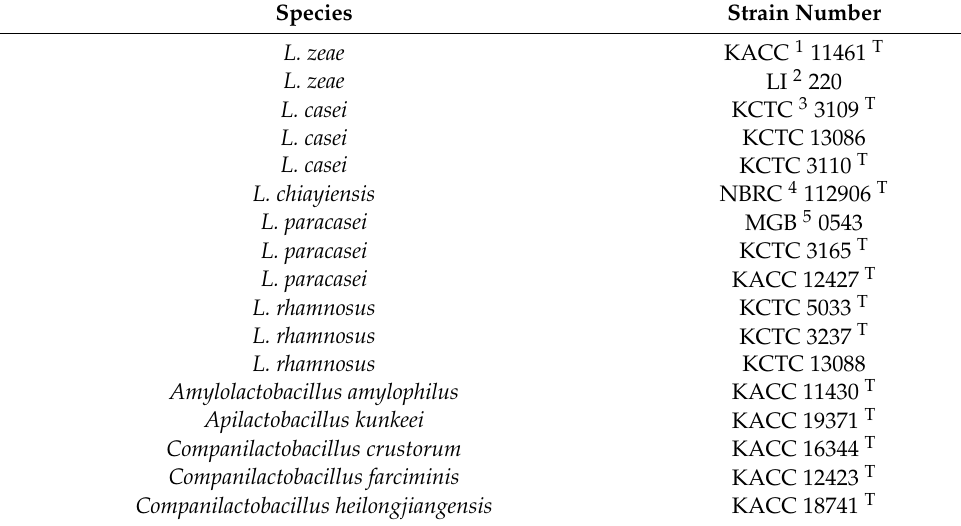
Table 2. List of bacterial strains used in this